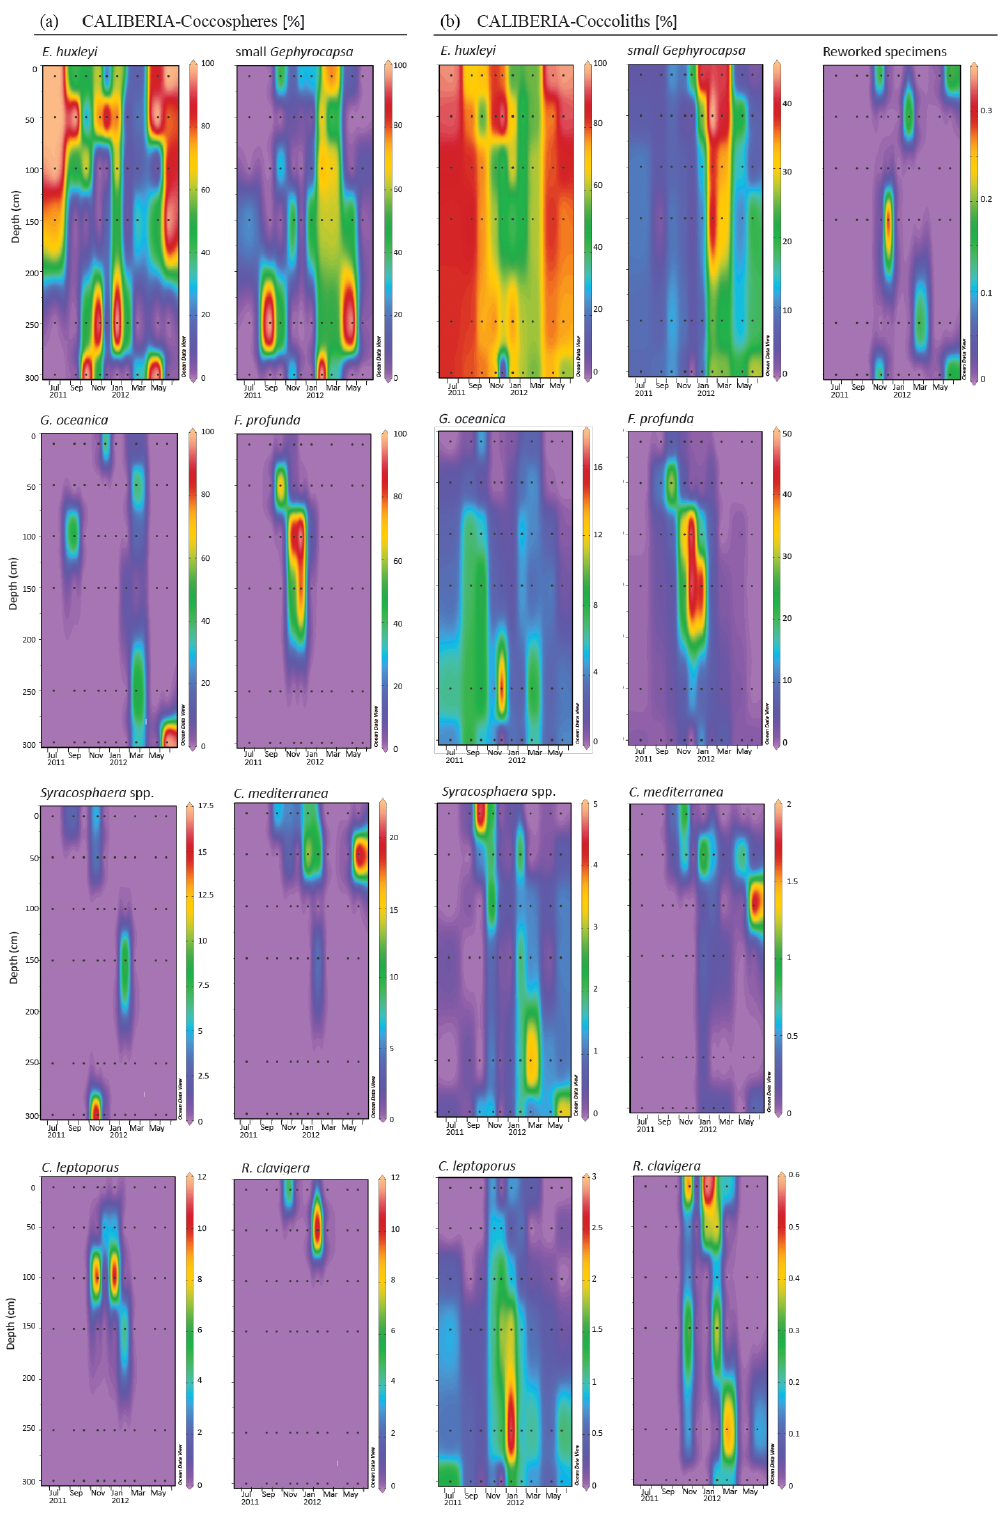
Figure 5. Relative abundance (%) of major species of coccospheres (a) and coccoliths (b) in CALIBERIA station. Black dots represent the sampling month and depth. Note that each colour bar has been scaled to the maximum and minimum values of its corresponding